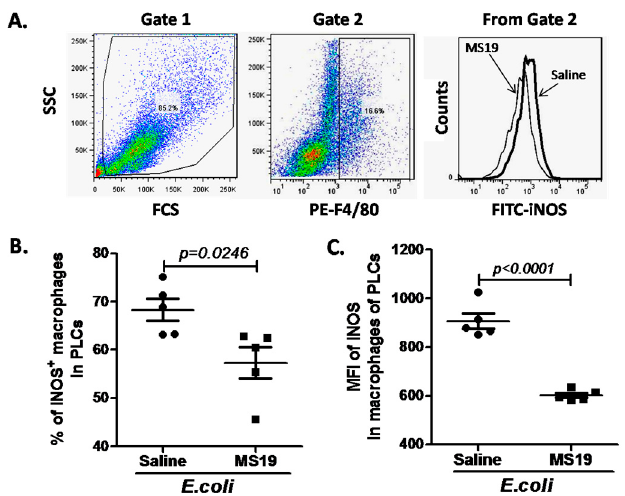
Figure 3. Down-regulatory effect of MS19 on the expression of inducible nitric oxide synthase (iNOS) in macrophages of PLCs from septic peritonitis model mice. The mice were intraperitoneally injected with E. coli at 1.6 × 10 8 CFUs. At 1 h post infection, the mice were intraperitoneally administrated with ( n = 5) or without ( n = 5) MS19 (10 µ g/mouse). At 8 h post- E. coli infection, the PLCs were harvested and then stained with PE-labeled anti-F4/80 mAb and fluorescein isothiocyanate (FITC)-labeled anti-iNOS mAb, followed by detection on a flow cytometry. ( A ) Gates for flow cytometry analysis; Left: Total of the PLCs. Middle: Ratios of iNOS + macrophages. Right: Ratios of iNOS + macrophages between the group of saline and MS19; ( B ) percentage of iNOS + macrophages in PLCs; ( C ) mean fluorescence intensity (MFI) of iNOS in macrophages of PLCs. Each point represents the mRNA level from one mouse. Mean ± SD was marked with bars. The data were analyzed by SPSS 19.0 and followed the Gaussian distribution.